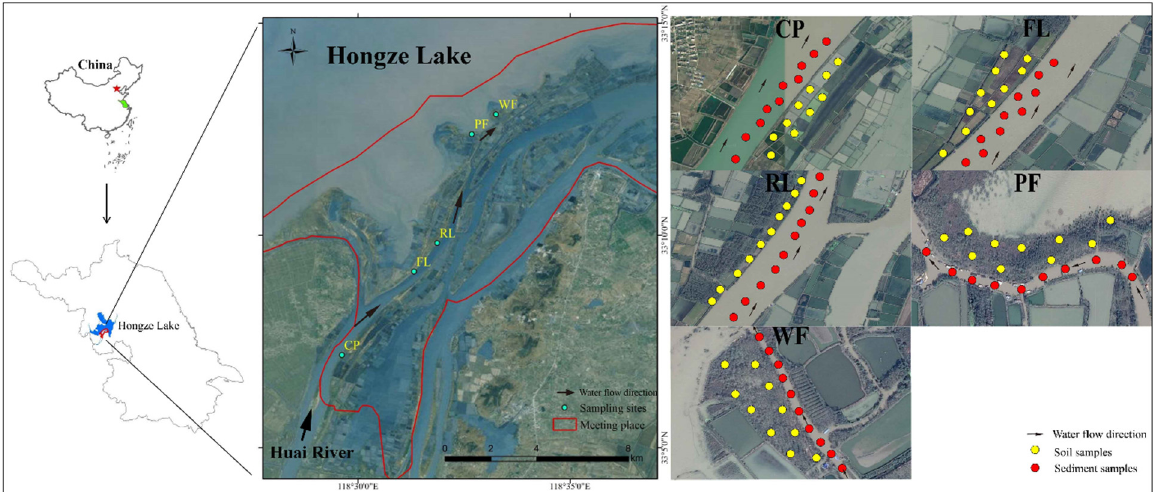
Figure 1. Location of the sampling sites for five types of land use (CP, FL, RL, PF, and WF) in this study. CP—Culture pond, FL—Farmland, RL—Reed land, PF—Poplar forest, and WF—Willow forest.